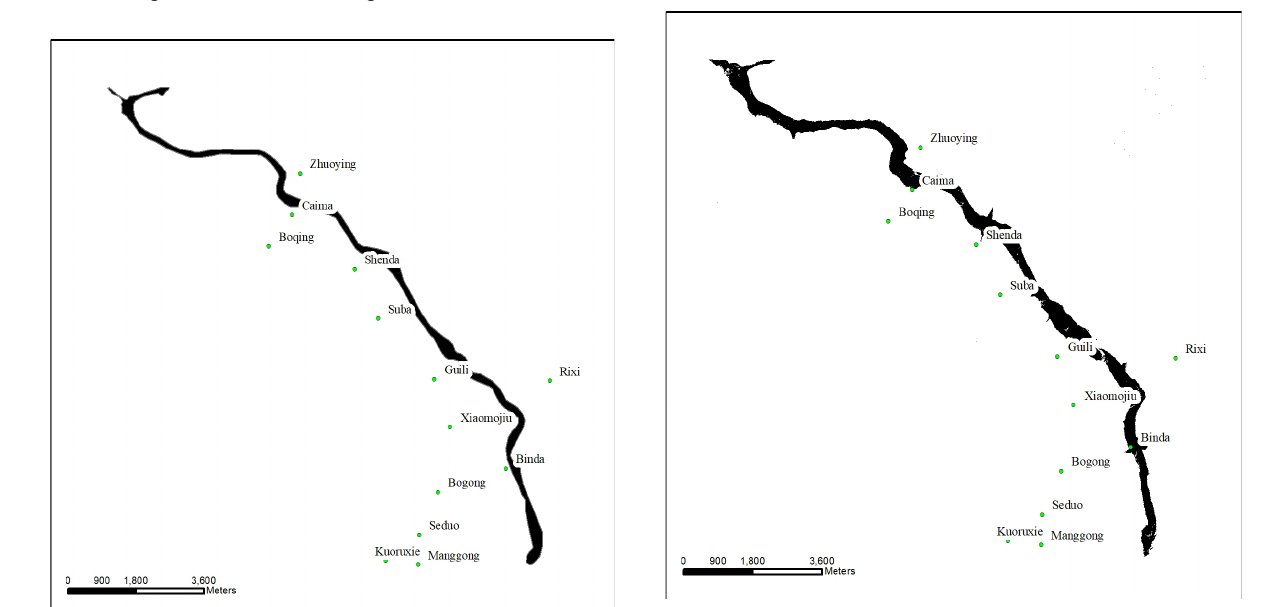
Figure 9. Water extraction result from BJ-2